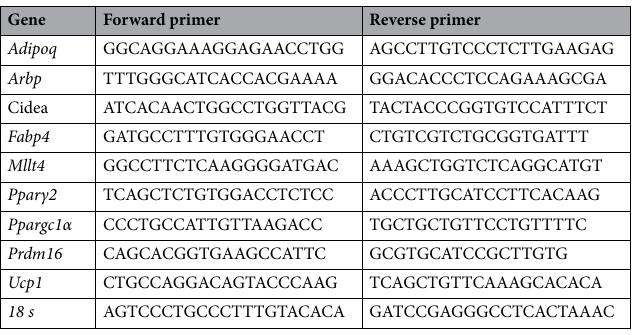
Table 1. Primers for